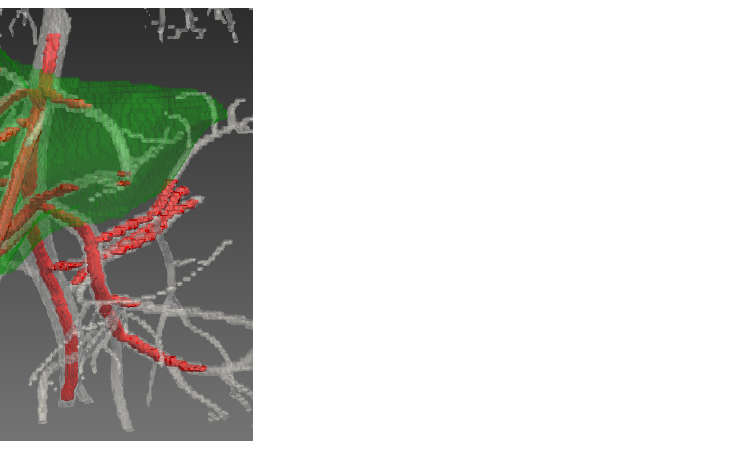
Figure 2. Generation of the metal masks inside blood vessels. The metal masks are shown in red, the initial blood vessel segmentation in white, and the liver in